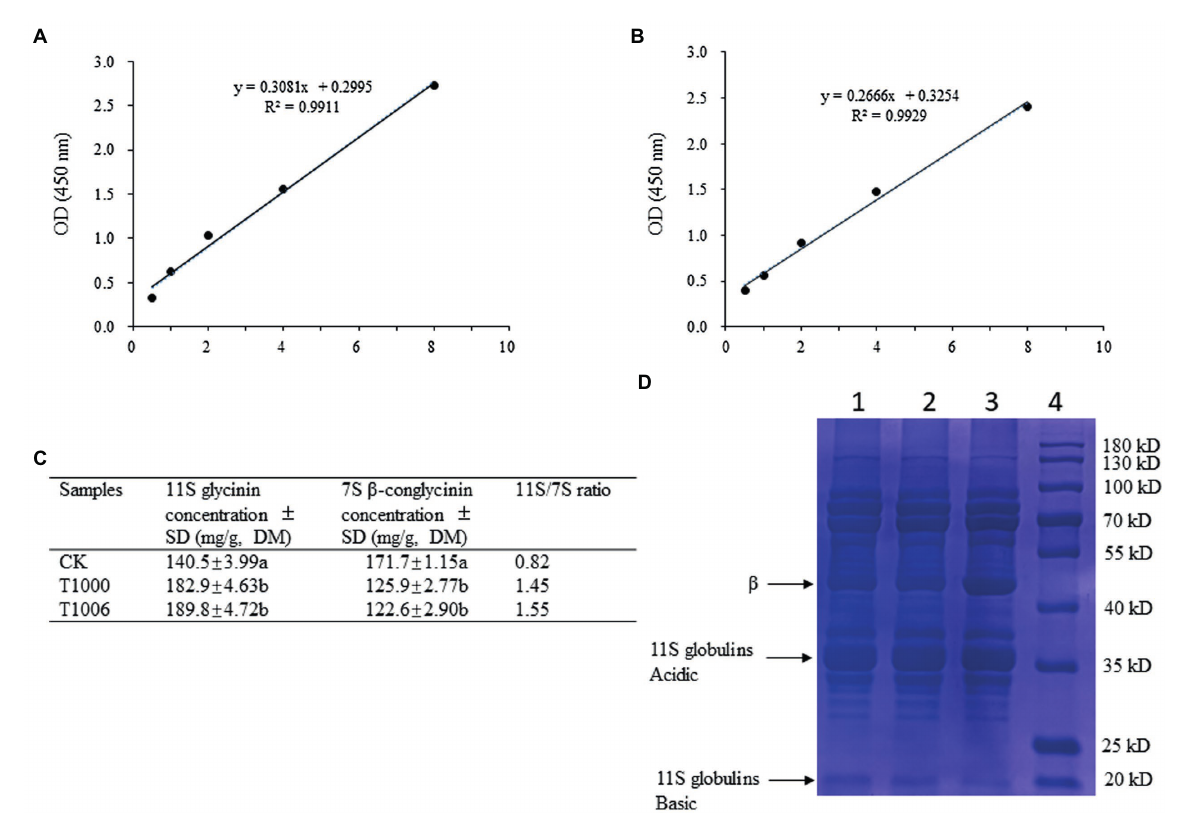
FIGURE 3 Analysis of the subunit composition of 7S β -conglycinin and 11S glycinin in soybean seeds. (A,B) are standard calibration curves of competitive ELISA for 7S and 11S globulins using polyclonal antibodies, respectively. (C) The content of 7S β -conglycinin and 11S glycinin in dry soybean seeds from different plants determined by ELISA results (3 replicates). The letters indicate the level of significance at the level p = 0.01. (D) Typical sodium dodecyl sulfate–polyacrylamide gel electrophoresis (SDS–PAGE, 12%) profiles of total proteins obtained from dry soybean seeds. The bands of the β subunit and the acidic and basic components of 11S globulins were noted. Lane 1, Lane 2, Lane 3, and Lane 4 represent T1000 and T1006 transgenic plants, ‘Tianlong No. 1’ and protein markers,